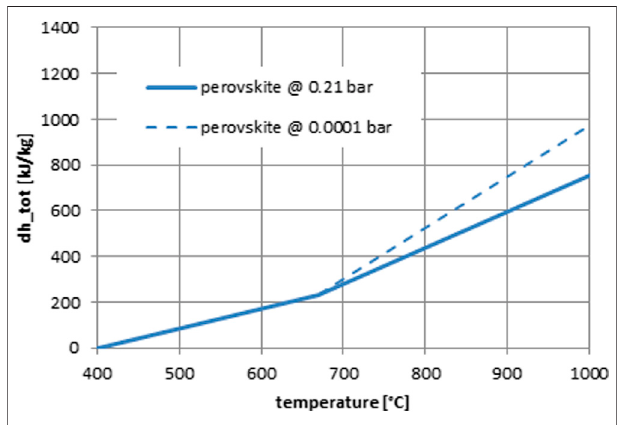
FIGURE 6 | Enthalpy data for perovskite redox